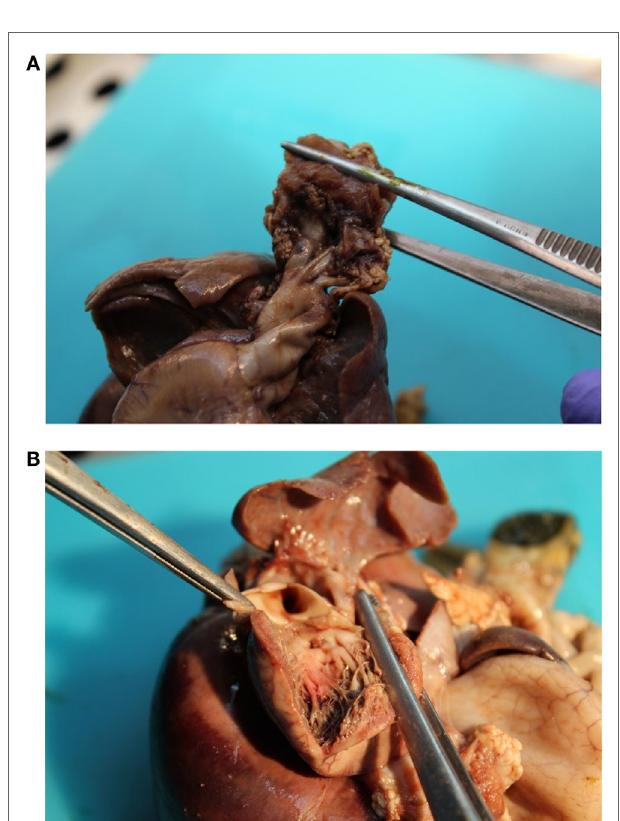
FIGURe 4 | (a) Malposition of the aortic orifice and s shape of the ascending aorta without transposition of great vessels. (B) Two punctate interventricular